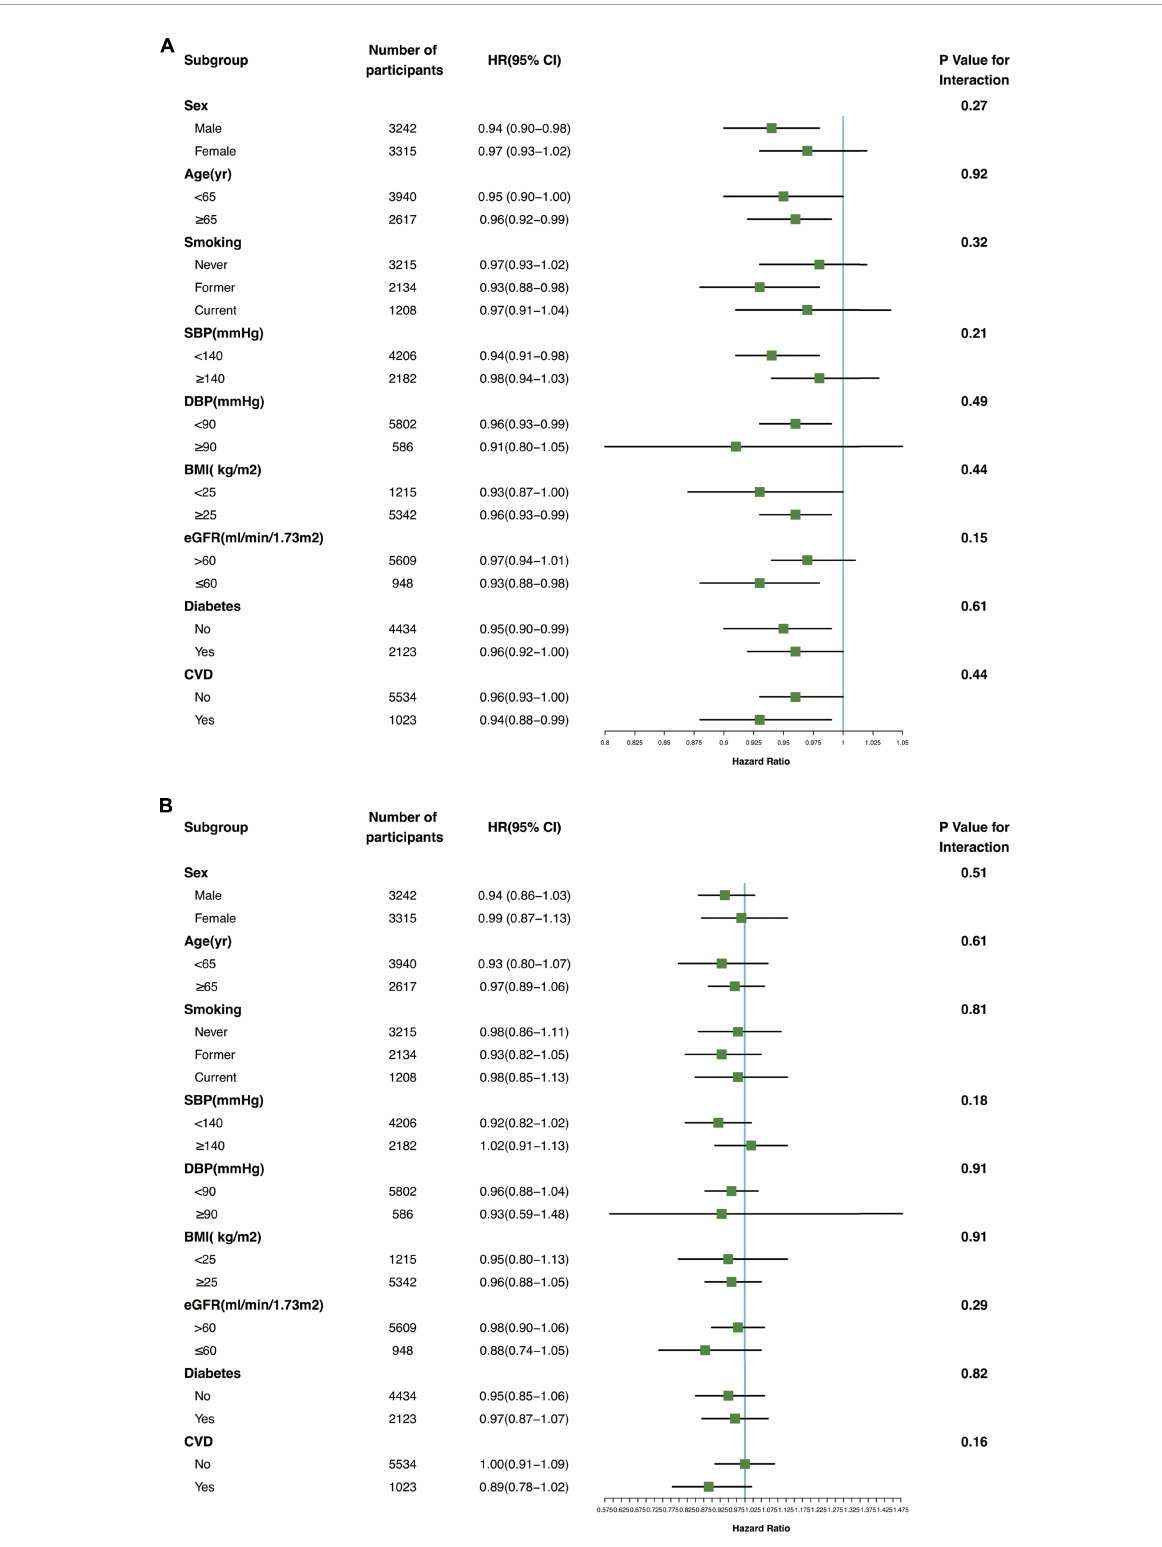
FIGURE4 Association of serum Klotho concentrations with all-cause mortality (A) and cardiovascular mortality (B) in various subgroups. yr, years old; SBP systolic blood pressure; DBP, diastolic blood pressure; BMI, body mass index; eGFR, estimated glomerular filtration rate; CVD, cardiovascular